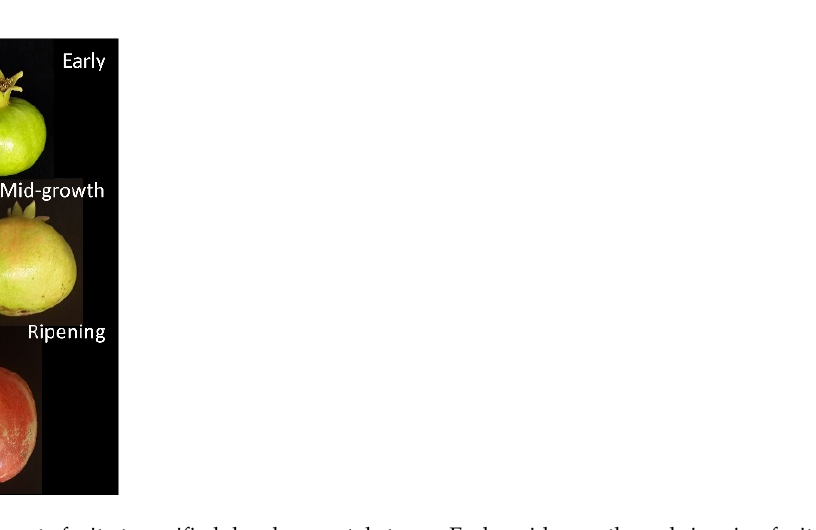
Figure 1. Pomegranate fruit at specified developmental stages. Early, mid-growth, and ripening fruit at 3, 11, and 22 weeks after petal fall, respectively. Bar = 5 cm.